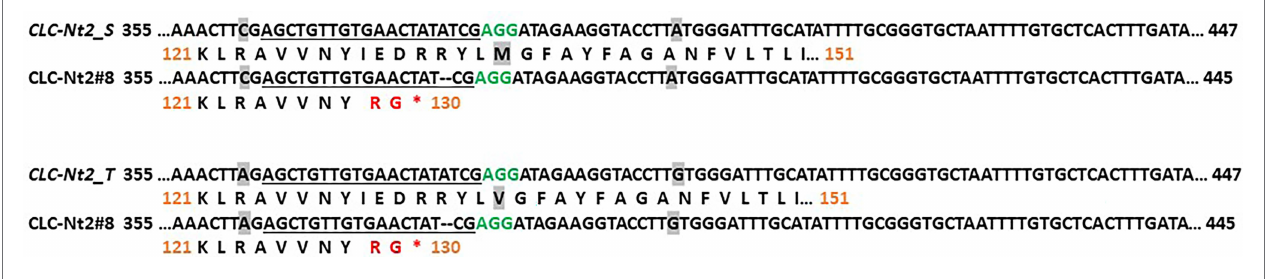
FIGURE 5 | CRISPR–Cas9-induced knockout (KO) mutations in CLCNt2_S and CLCNt2_T . The region of the WT CLCNt2 sequence that was targeted by the CRISPR–Cas9 construct is shown on top, with the mutant variants found in line CLCNt2#8 underneath. The 20-bp CRISPR–Cas9 target sequence is underlined, and the PAM site is in green type. Dashes represent bases that have been deleted. WT amino acids are shown in black type; unique amino acids predicted to be present on the C-terminus of the mutant truncated proteins because of frameshifts caused by the two deleted base pairs are shown in red type. Asterisks represent termination codons. Numbers in black correspond to the cDNA sequence beginning at the ATG start codon, and orange numbers indicate the amino acid position. Nucleotides and amino acids that are polymorphic between the CLCNt2-S and CLCNt2-T isoforms are shaded